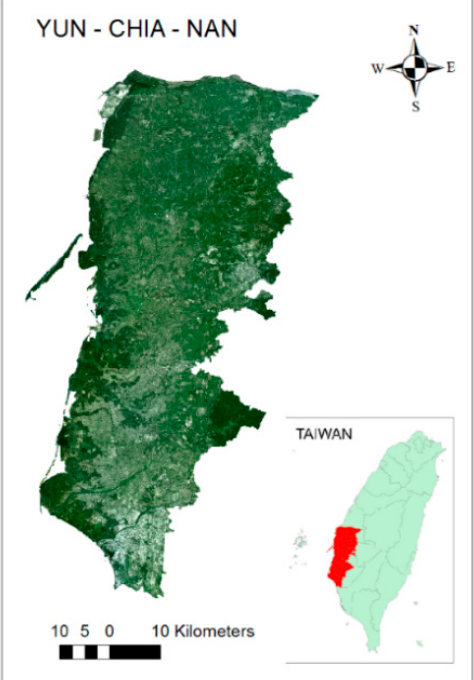
Figure 1. Geographical location of study area with Standard True Color Composite generated from Landsat 8 OLI data (19 October 2014).